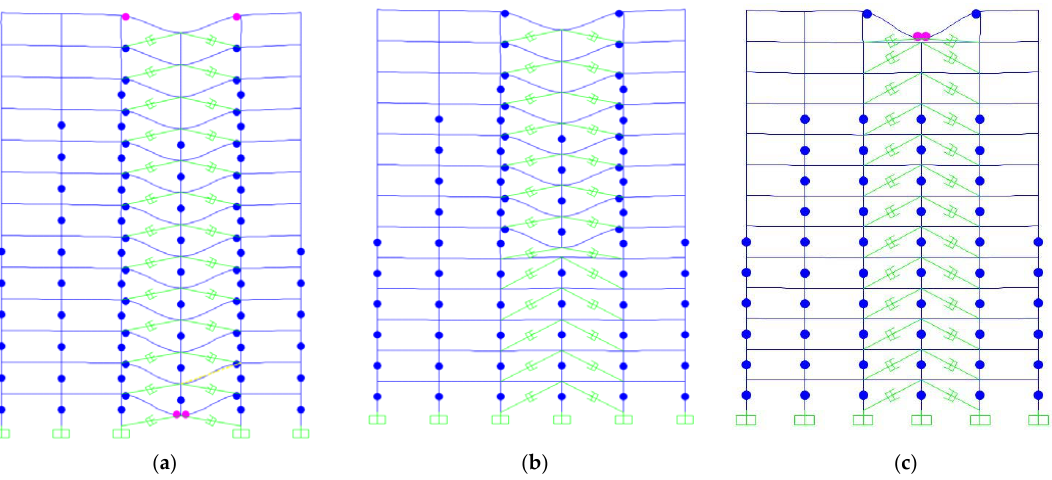
( c ) Figure 14. Hinge formation in the frame with CFRP exposed to column removal in ( a ) story one, ( b ) story six, and ( c ) story thirteen. 3.1. Performance Level of the Frames The damage levels of members were analyzed for the non-linear analytic techniques using various performance levels such as immediate occupancy (IO), life safety (LS), and collapse prevention (CP). The performance level of the structure should not exceed col- lapse prevention according to GSA rules, or structural members will be classified as seri- ously failed [1]. In all cases, the plastic hinge formation is illustrated in 2D frames. Figure 7 shows the removal of columns on different stories in a moment-resisting frame (bare frame). After removing the column on the first floor, all the beams in the span were failed at collapse prevention, and the span completely collapsed at all floors above. The removal of the column on floor six caused the beams to fail and reach the life safety point at all floors above, and the structure could not redistribute the forces well. Moreover, removing the column on floor thirteen puts its beam almost in a state of complete collapse.